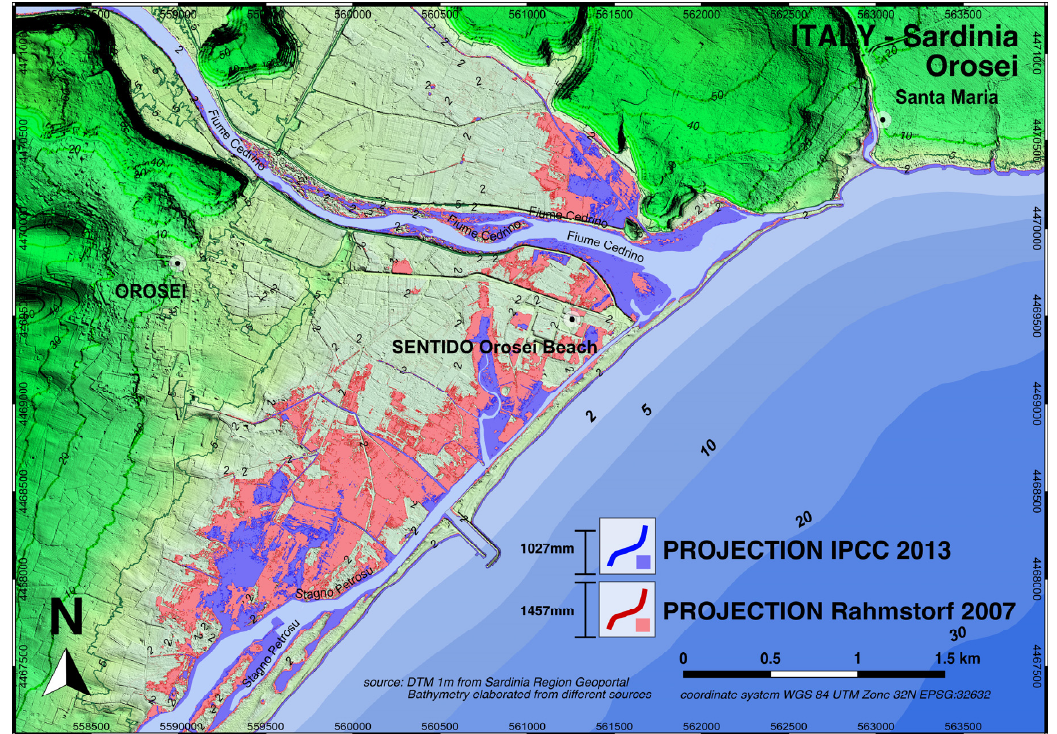
Figure 3. Map 3 Orosei (Sardinia Italy, see also Figure 1 for location). The potential submersion area, using Rahmstorf 2007 projections are 3.1 km 2